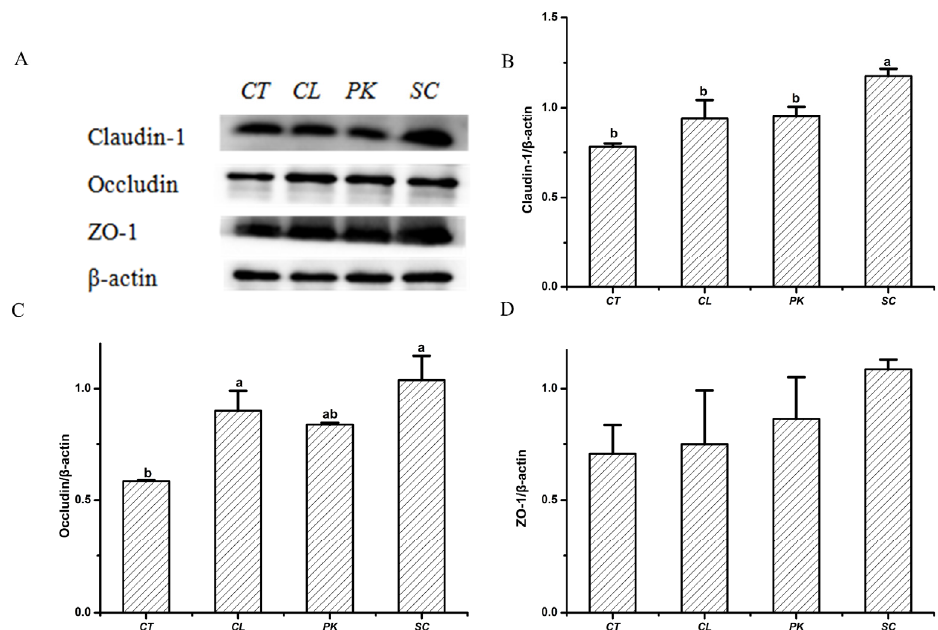
layers. ( A ) Western blotting images of Claudin–1, Occludin and ZO–1. ( B ) Relative expression of Figure 1. Effects of the yeast strains on the tight junction proteins expression of HT − 29 cell mono- ( B ) Claudin–1, ( C ) Occludin, ( D ) ZO–1. Different lowercase letters marked on the column represent layers. ( A )Western blotting images of Claudin − 1, Occludin and ZO − 1. ( B )Relative expression of ( B ) significant difference ( p < Claudin − 1, ( C ) Occludin, ( D ) ZO − 1. Different lowercase letters marked on the column represent significant difference ( p < 0.05).